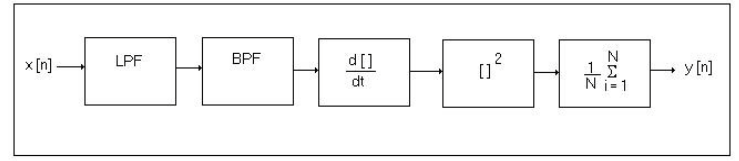
Figure 1. Block diagram of the Pan and Tompkins